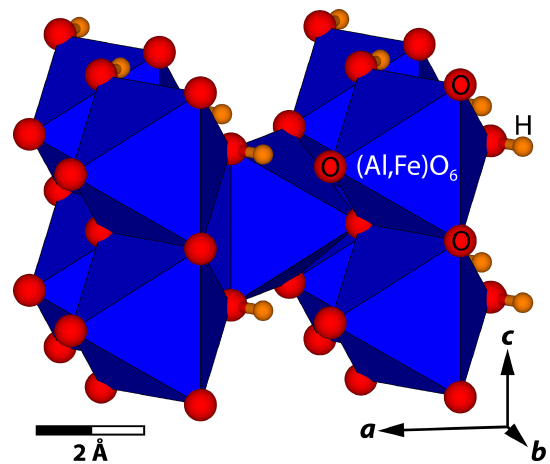
Figure 3. Crystal structure of δ -(Al,Fe)OOH. Atomic positions were taken from Komatsu et al. (2006) and lattice parameters from Table 1 (X1). The positions of oxygen atoms are shown as red spheres, the positions of hydrogen atoms are shown as orange spheres, and (Al,Fe)O 6 octahedra are shown in blue. The crys- tal structure was drawn with VESTA (version 3.4.6; Momma and Izumi, 2011). Note the edge and corner sharing of (Al,Fe)O 6 octa-